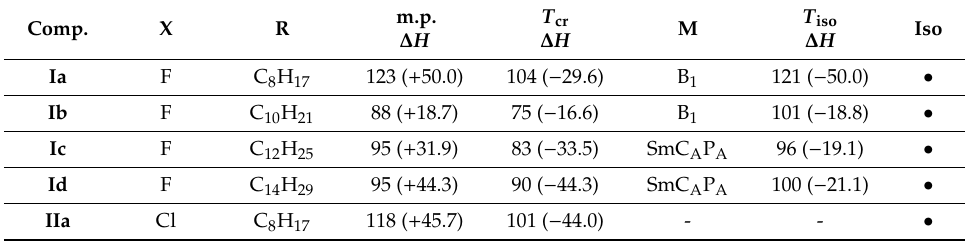
Table 1. Melting point, m.p., the phase transition temperature from the isotropic (Iso) phase to the mesophase, T iso , and temperature of crystallization, T cr , in ◦ C, and corresponding enthalpy changes, ∆ H in kJ mol − 1 , detected on the second temperature runs, are in